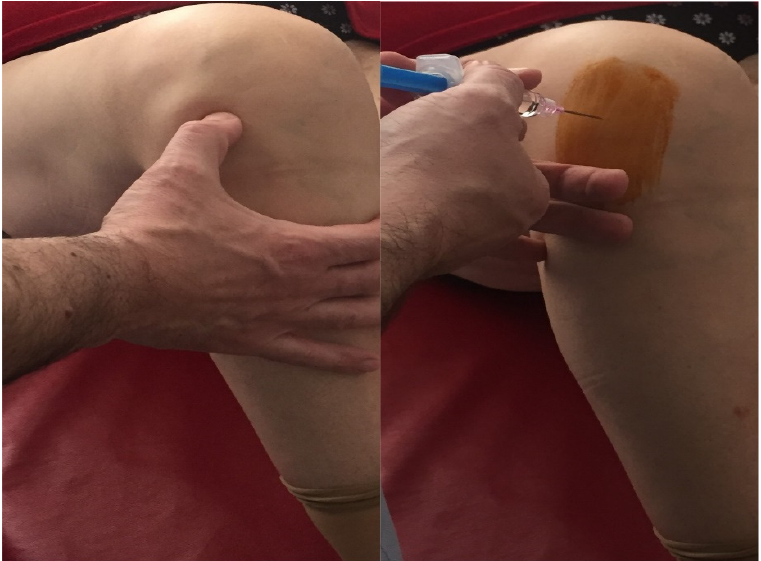
Figure 4. Antero-lateral portal HA injection under routine aseptic conditions.